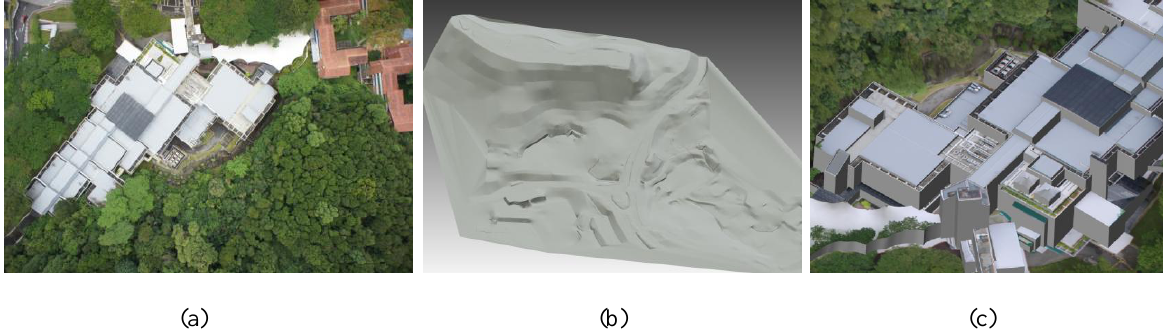
Figure 5: Results of NUS campus modeling: (a) one of the UAV images; (b) measured terrain; (c) zoom-in result of a textured building